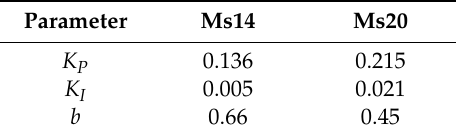
Table 9. PI controller parameters for Case 4.